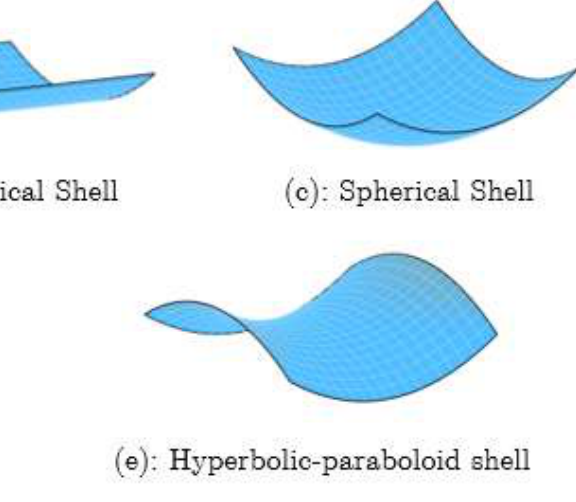
Figure 2. Forms of various plate/shells.